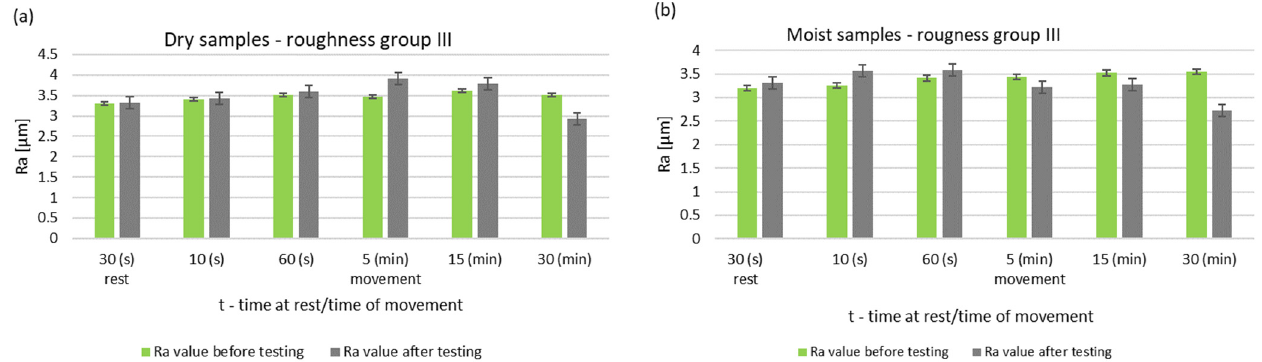
Figure 10. Changes in the value of the parameter Ra of steel pins for roughness group III (Ra = 3.21–3.62 µ m): ( a ) tests performed in dry conditions, ( b ) tests performed with moist graphite rings.